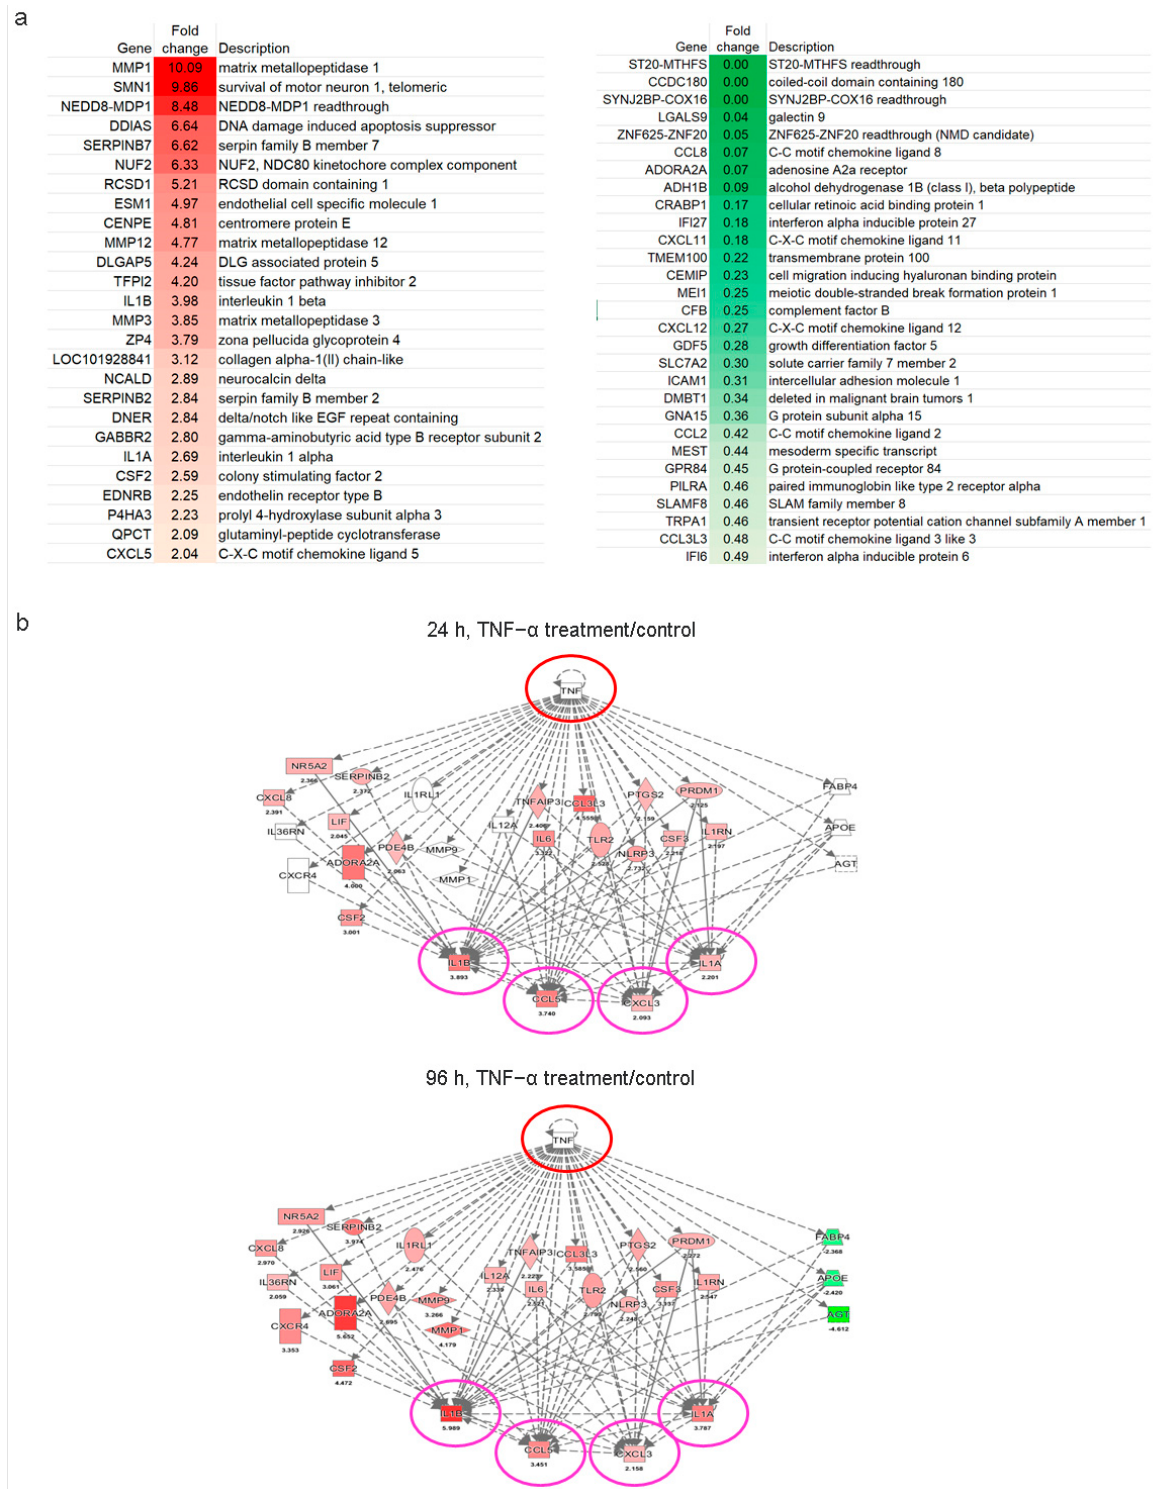
Figure 4. RNA sequencing–based gene expression profiling of ADSCs subjected to TNF- α treatment. ( a ) Regulated progenitor genes in TNF- α treated ADSCs for 24 h. ( b ) Pathway analysis of representative genes in ADSCs that responded to TNF- α treatment performed for 24 h and 96 h, proposed using the Ingenuity software (Qiagen, Hilden, Germany). Red and green colored shapes indicate up- and downregulated gene expression, respectively. The red and pink circles indicate the stimulator (TNF- α ) and key mediators in the signaling network (IL-1A, IL-1B, CCL5, and CXCL3). The number under each symbol indicated on the maps is the ratio fold change between the treatment and control groups.